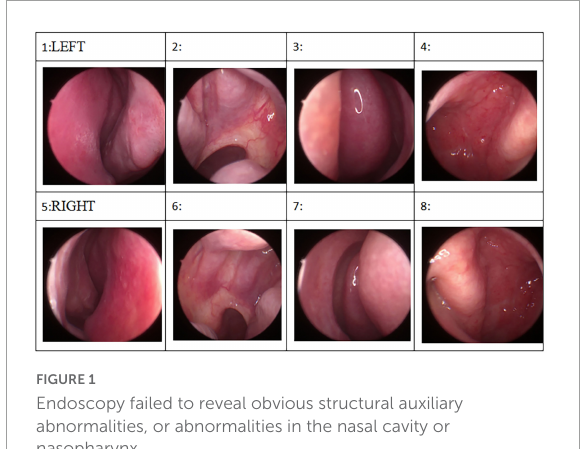
FIGURE1 Endoscopy failed to reveal obvious structural auxiliary abnormalities, or abnormalities in the nasal cavity or